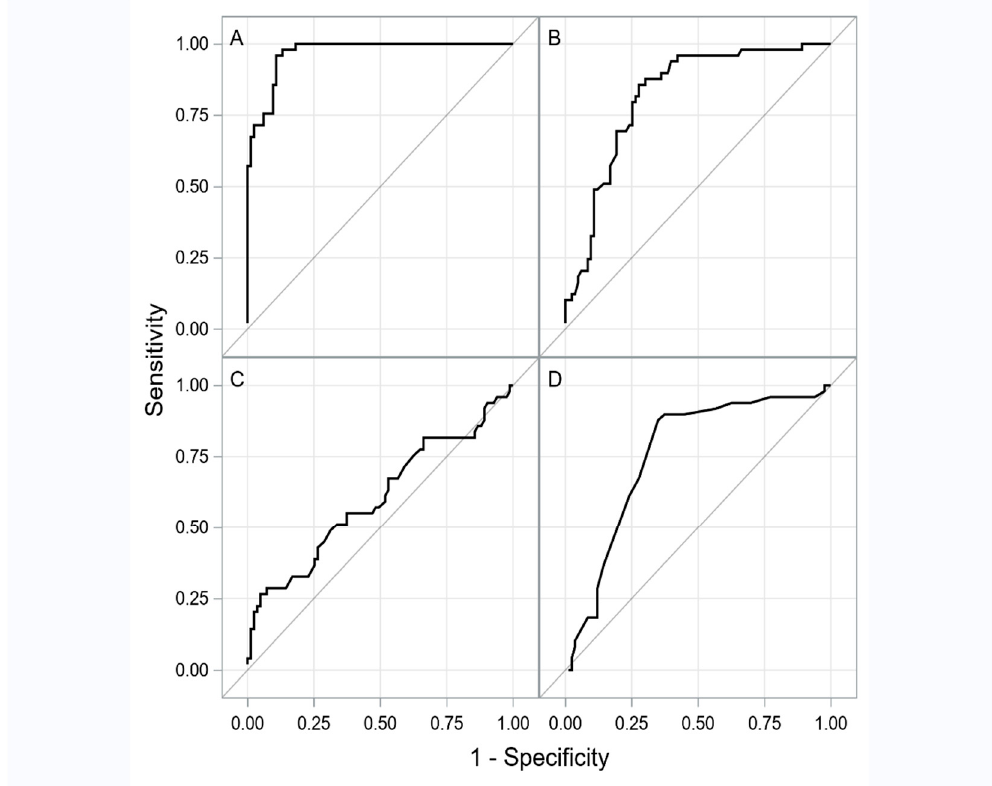
Figure 1. The ROC curves for tenascin C ( A ), fibrinogen ( B ), creatinine ( C ) and right ventricular end-diastolic dimension ( D ).